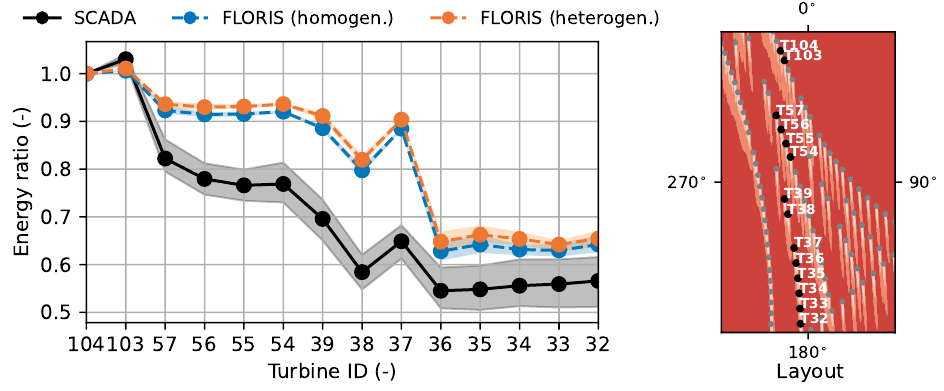
Figure 9. Energy ratios of Turbines 104, 103, 57, 56, 55, 54, 39, 38, 37, 36, 35, 34, 33, and 32 for a narrow wind direction sector of 348.3 ◦ to 3.3 ◦ . Turbine 104 acts as the reference turbine, and the reference wind direction is the average of the wind direction measurements of the array of turbines. The shaded regions represent 90% confidence interval bounds obtained through